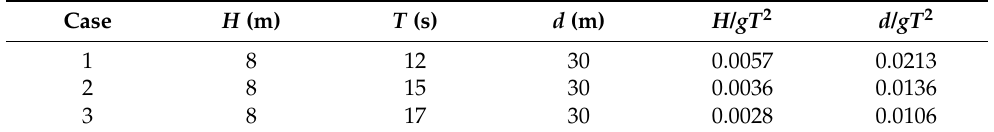
Table 4. Parameters of waves.